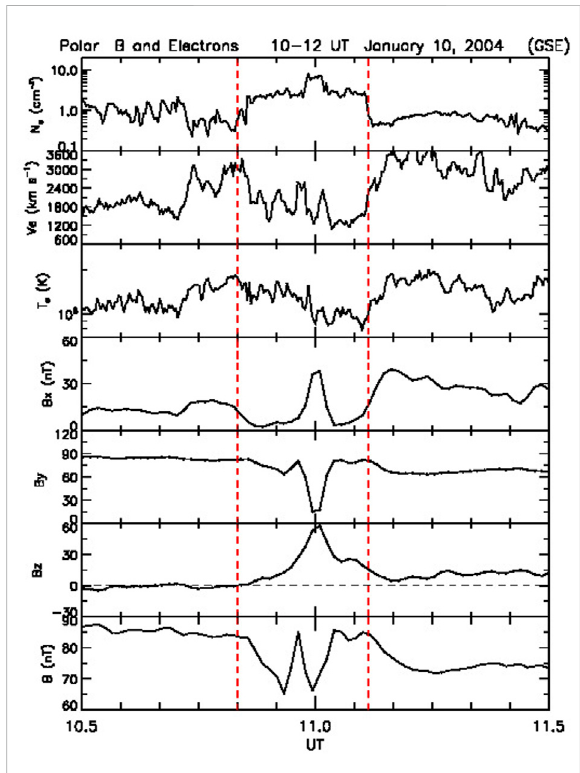
FIGURE 7 DatafromtheMFEandHYDRAinstrumentsonPolar.Electron data: density, bulk speed and temperature. Magnetic fi eld: Components in GSE coordinates and total fi eld. The vertical guidelines bracket the interval where the clear changes in all these parameters suggest that Polar is sampling the CS-structure observed about 48 min earlier by